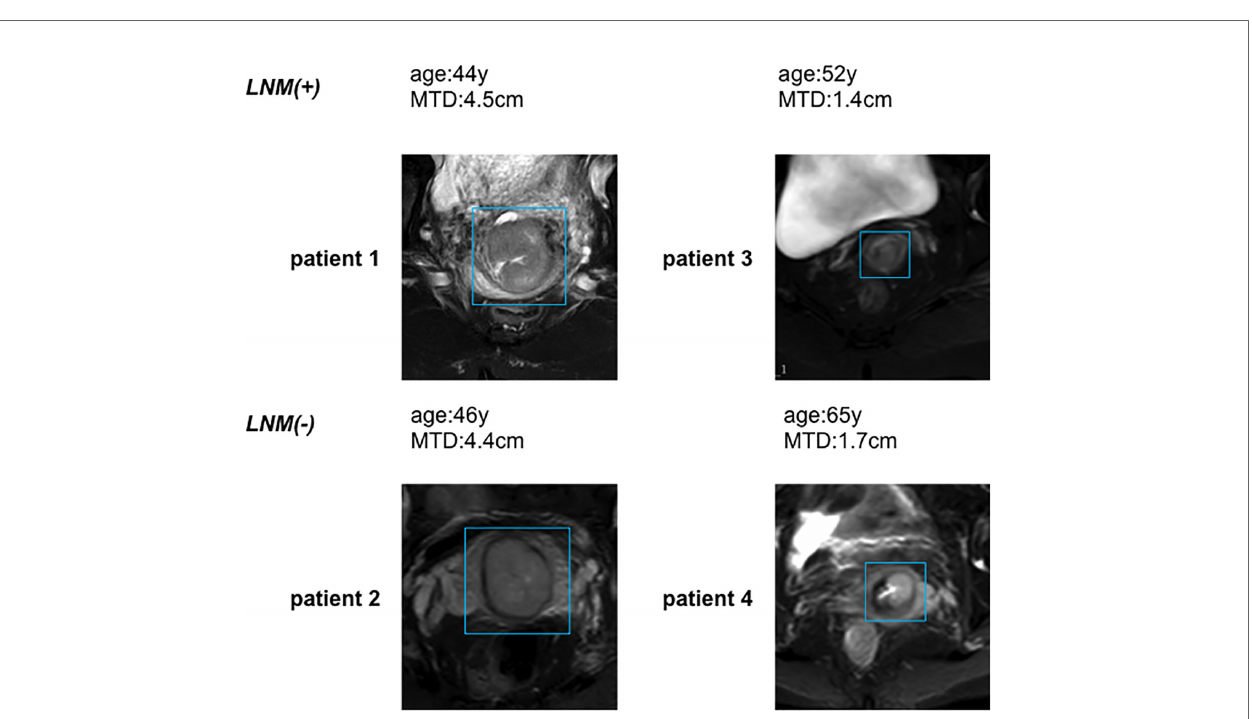
FIGURE 2 | Representative MRI images in LVSI(-) and LVSI(+)